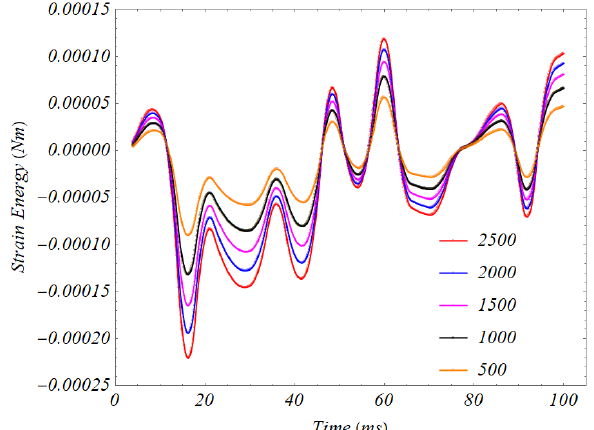
Fig. 13. Strain energy against time for various drop distances with three cellphone casing laminates.